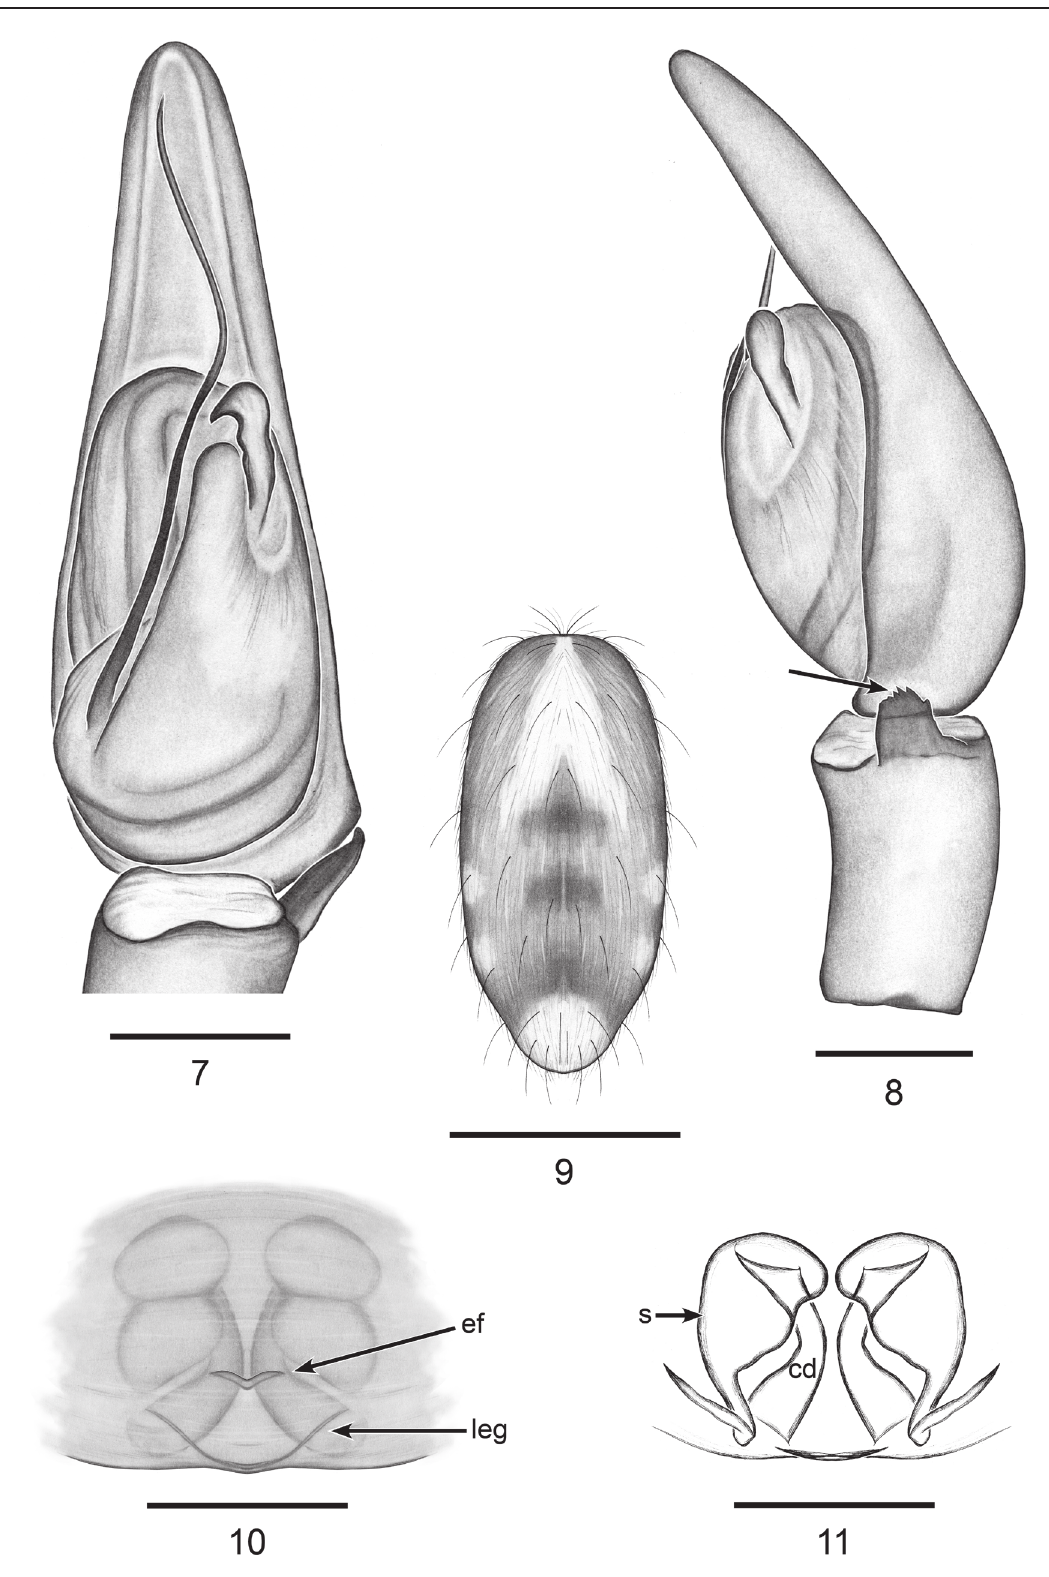
Figs 7–11. Katissa puyu sp. nov. 7 . ♂, palp, ventral view. 8 . ♂, palp, retrolateral view (arrow points to the serrated retrolateral tibial apophysis). 9 . ♂, abdomen, dorsal view. 10 . ♀, epigynum, ventral view. 11 . ♀, internal genitalia, dorsal view. Scale bars: 7–8, 10–11 = 0.1 mm; 11 = 0.5